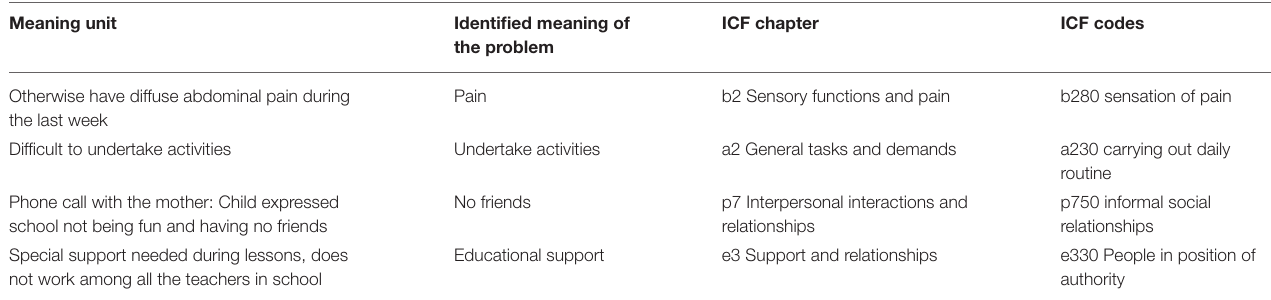
TABLE 1 | Examples of the coding process. Meaning